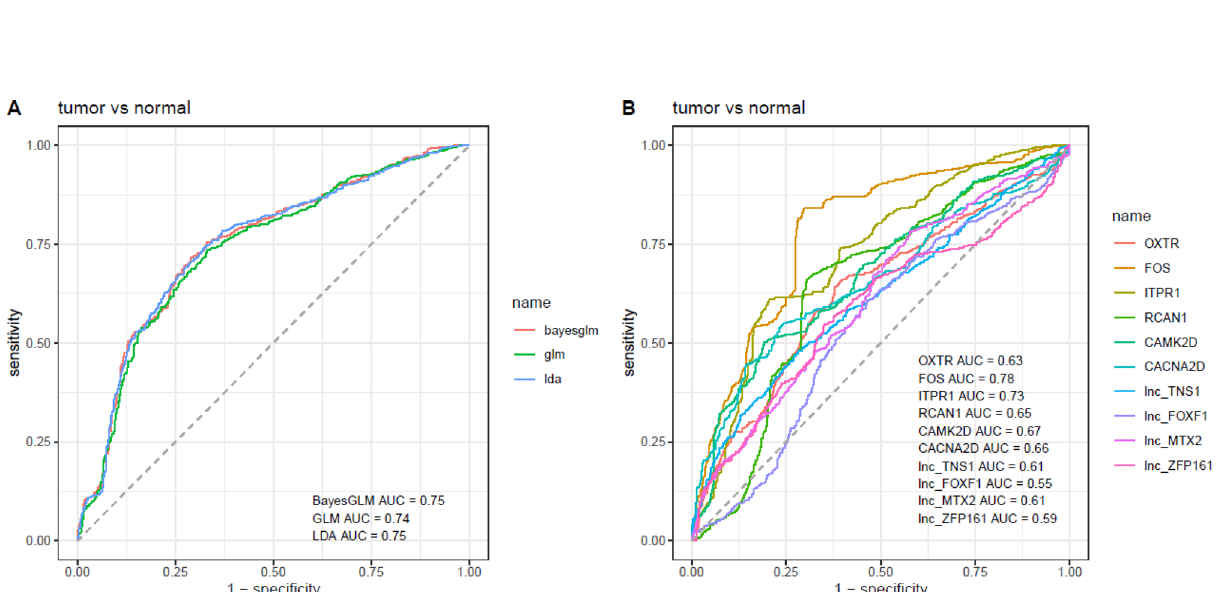
Figure 4. Efficacy of three predictive models in predicting the diagnostic power of oxytocin-related genes (A) and the obtained AUC values for each gene (B)